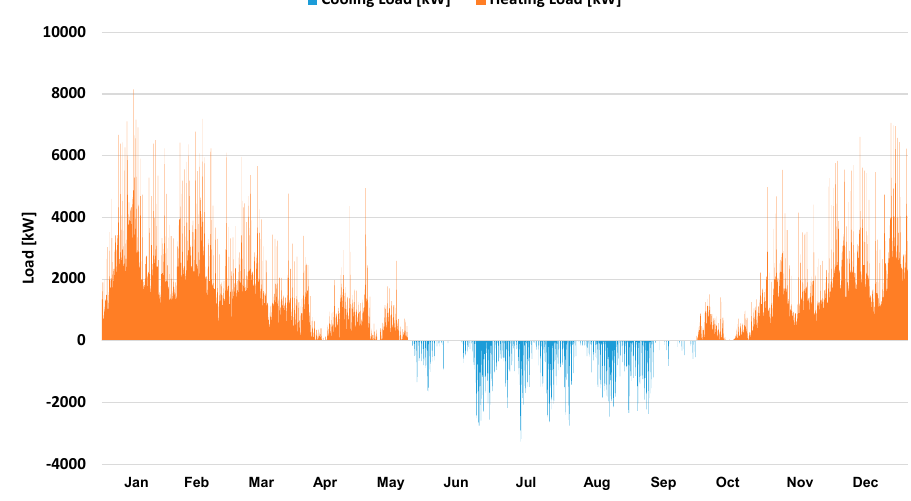
Figure 1. District heating and cooling (DHC) load profile.